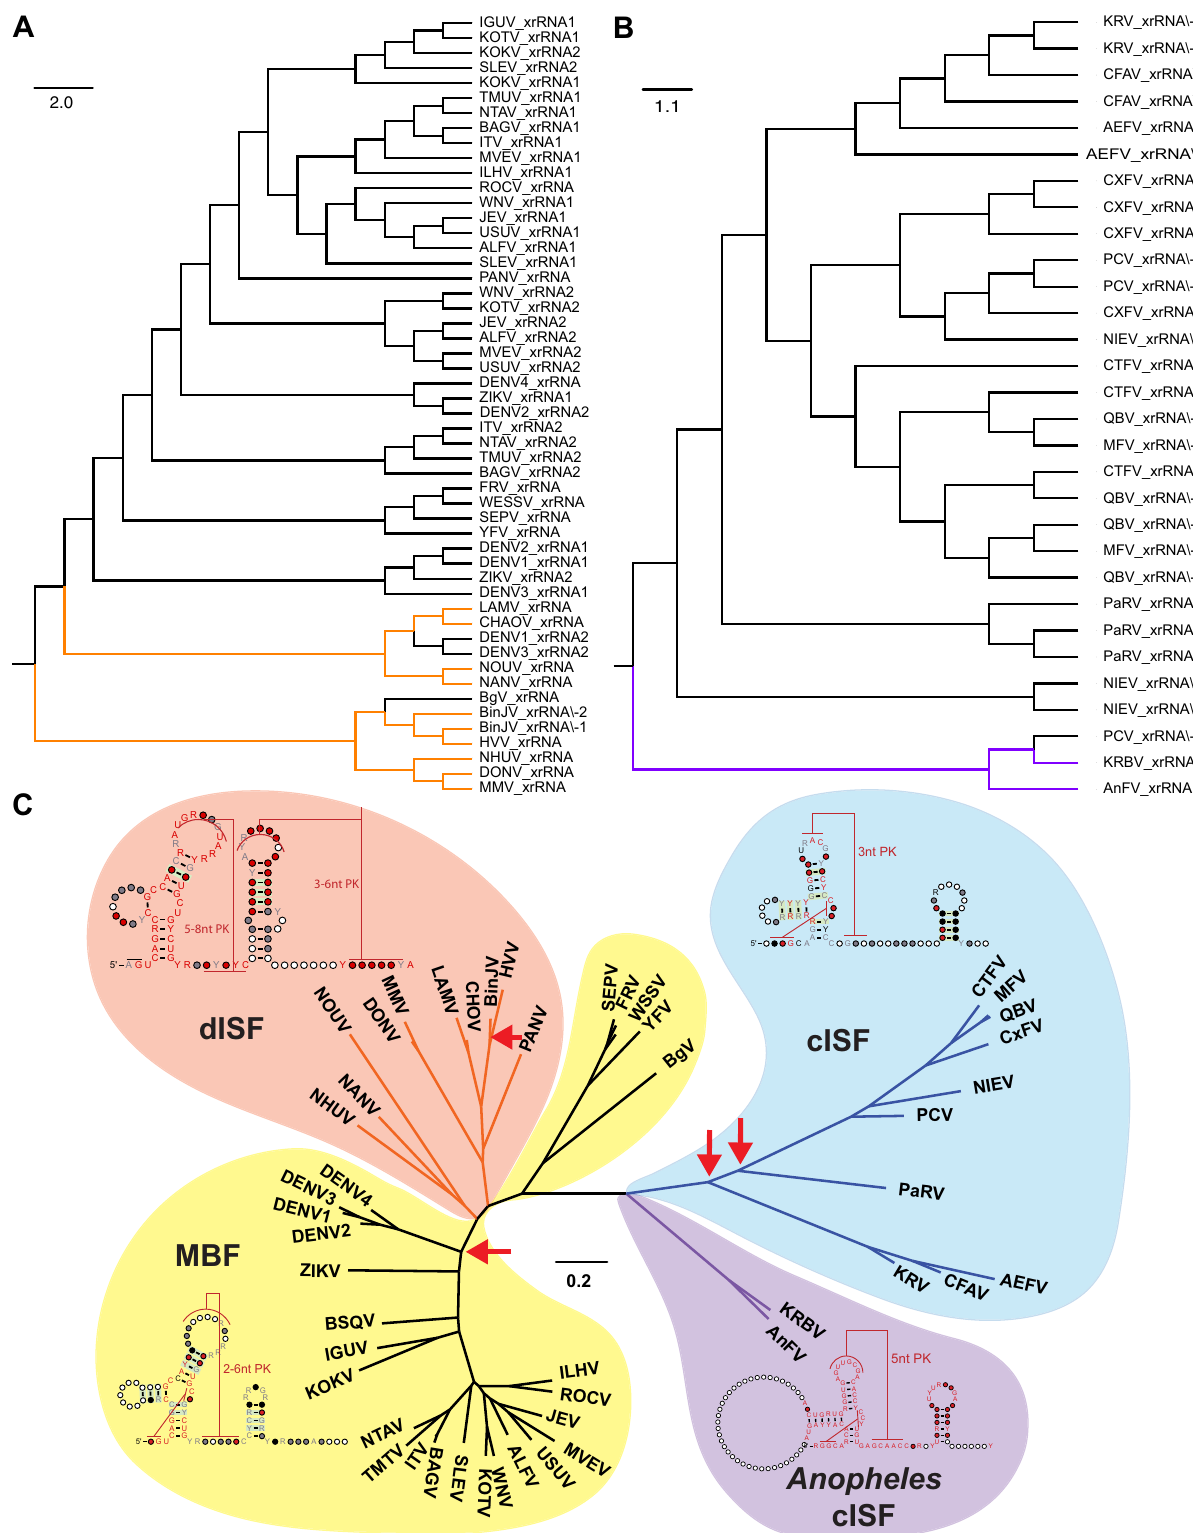
Fig. 6 Phylogenetic analysis of fl avivirus xrRNAs and 3 ’ UTRS. A Structure-based phylogenetic tree of cISF xrRNAs. Purple - Anopheles -associated ISFs. B Structure-based phylogenetic tree of MBF and dISF xrRNAs. Orange - dISF clades. C Consensus Maximum-Likelihood phylogenetic tree of fl avivirus 3 ’ UTRs. Arrows indicate xrRNA duplication